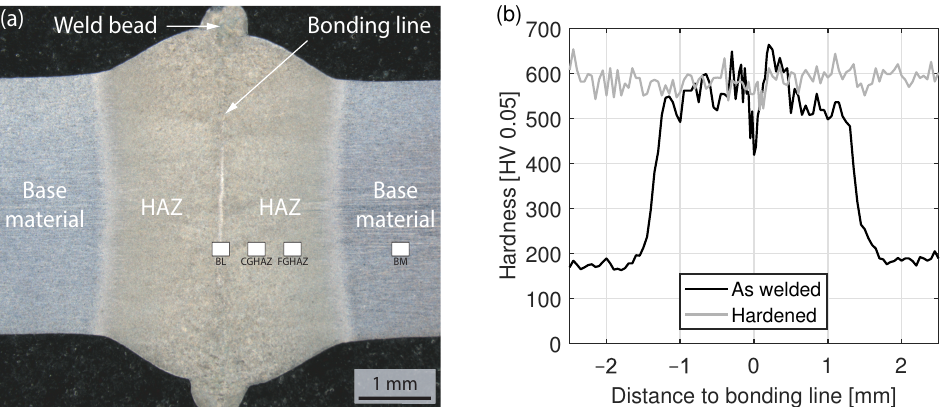
Figure 3. ( a ) Optical image of the as-welded sheet, etched with a 3% nital solution, ( b ) Hardness profile in the as-welded and hardened